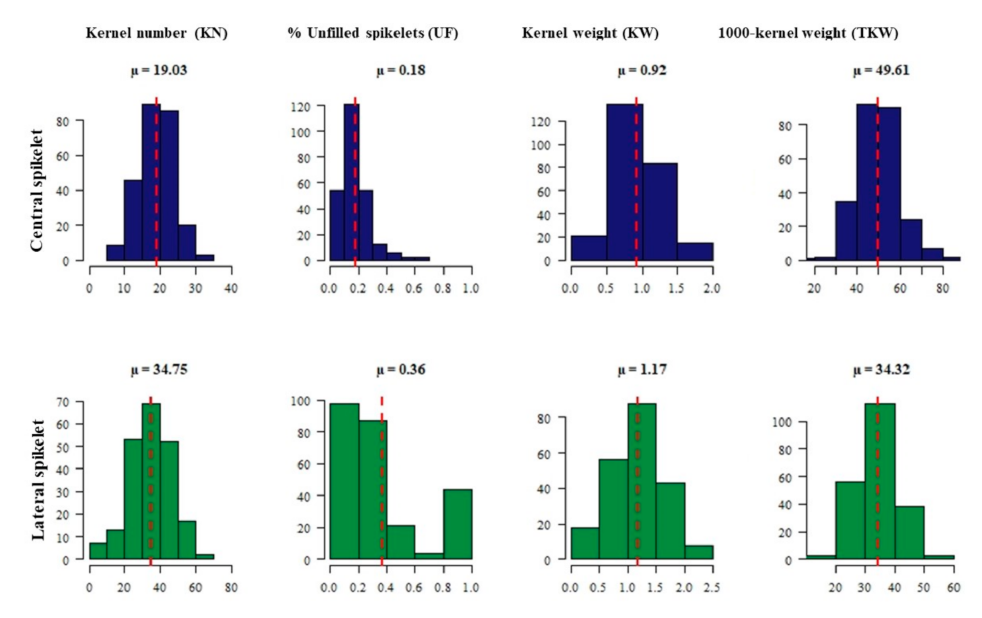
Figure 1. The phenotype’s frequency distribution histogram of kernel number (KN), percentage (%) of unfilled spikelets (UF), kernel weight (KW) and 1000-kernel weight (TKW) for central (blue color) and lateral (green color) spikelets among 254 intermedium -spike barley